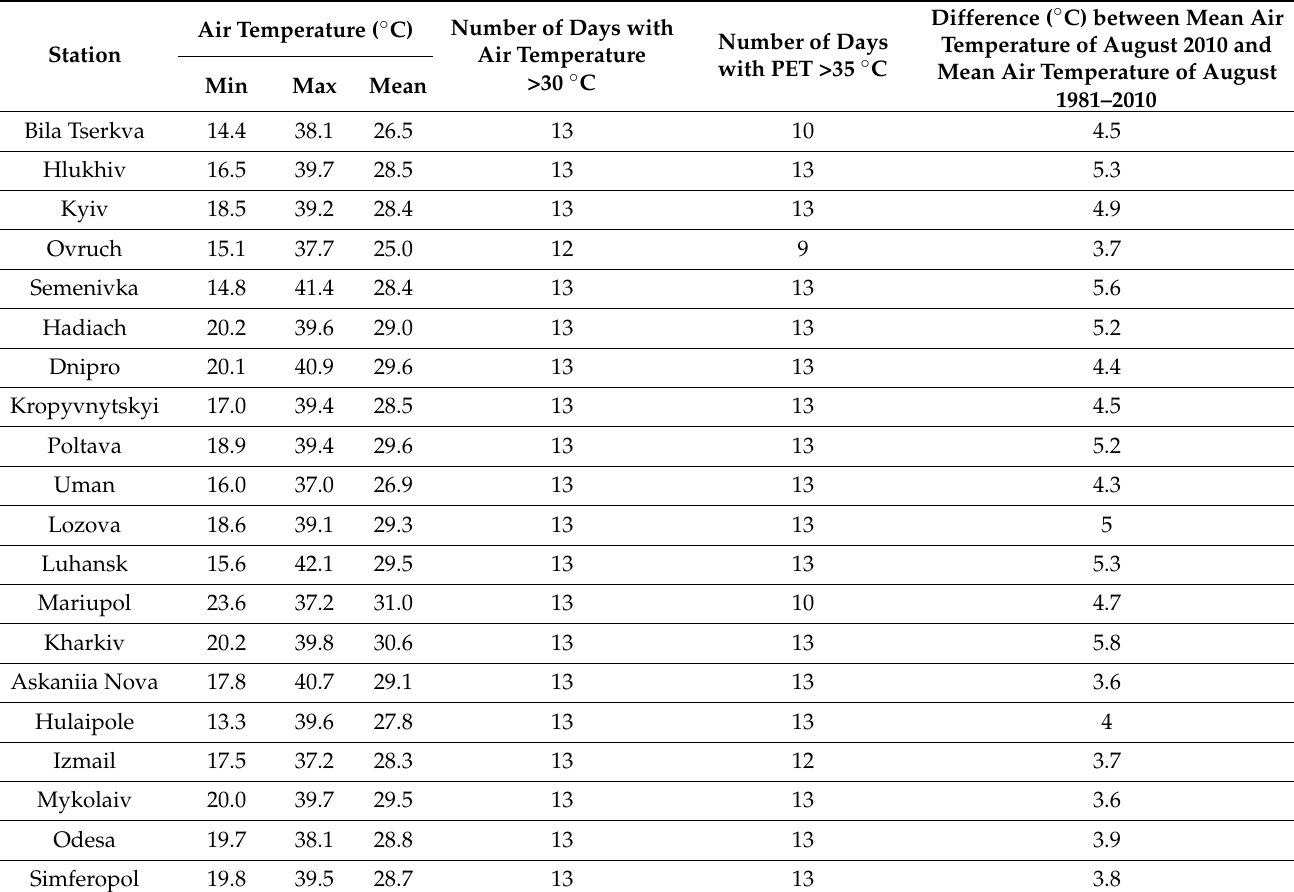
Table 3. Characteristics of air temperature regime and number of days with PET >35 ◦ C during the mega-heat wave in 2010 (31 July to 12